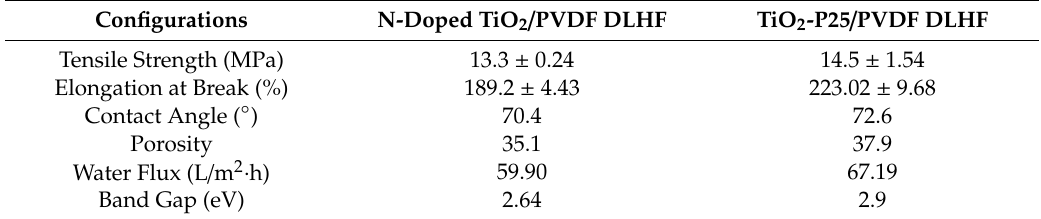
Table2. PerformanceofN-dopedTiO 2 / PVDFDLHFincomparisonwithTiO 2 -P25 / PVDFDLHFmembrane.